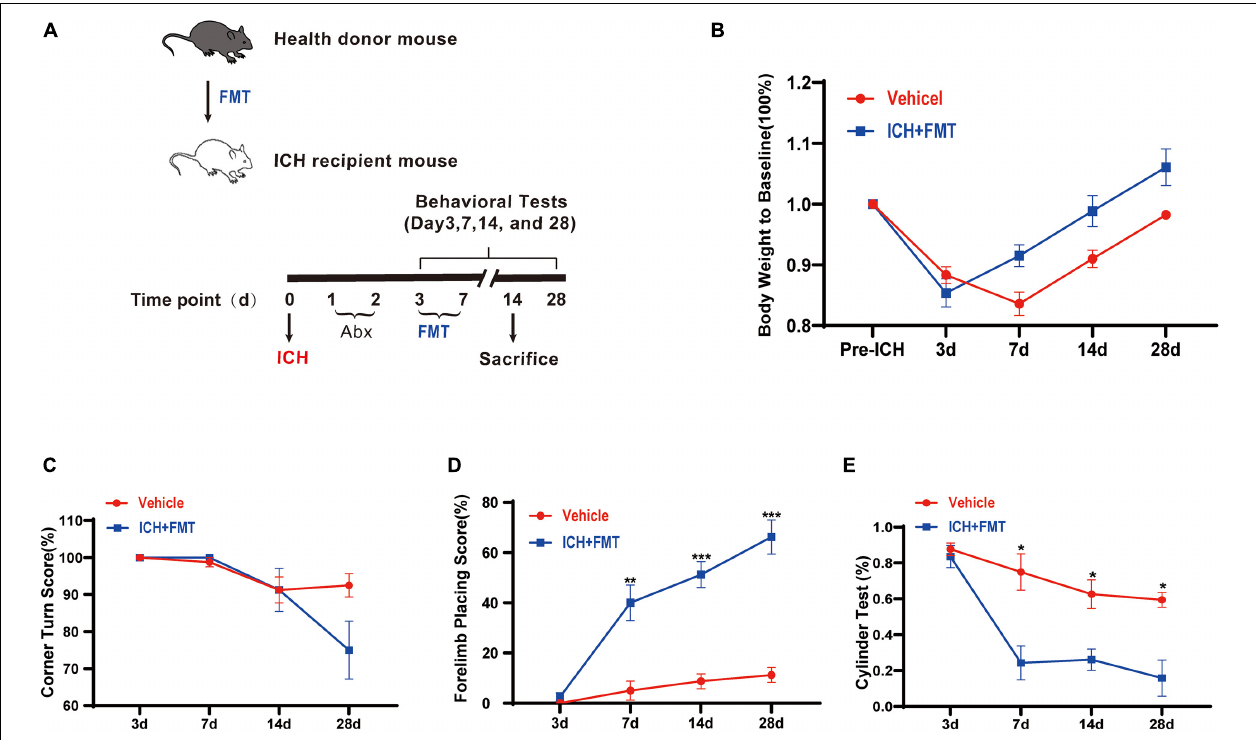
FIGURE 6 | Transplantation of healthy fecal microbiome improves neurobehavioral outcomes after ICH. (A) Experimental protocol for fecal microbiota transplant from healthy donor mice to recipient ICH mice. (B) Changes in body weight ( n = 8). (C–E) Recolonizing ICH mice with the gut microbiota obtained from healthy donors significantly reduced behavioral performance as assessed by the corner turn test (C) , forelimb placing test (D) , and cylinder test (E) after FMT on 3, 7, 14, and 28 days after ICH. ( n = 8 per groups, 2 individual experiments). Data are expressed as the mean ± SEM. * P < 0.05. ** P < 0.01. *** P < 0.001 vs . vehicle